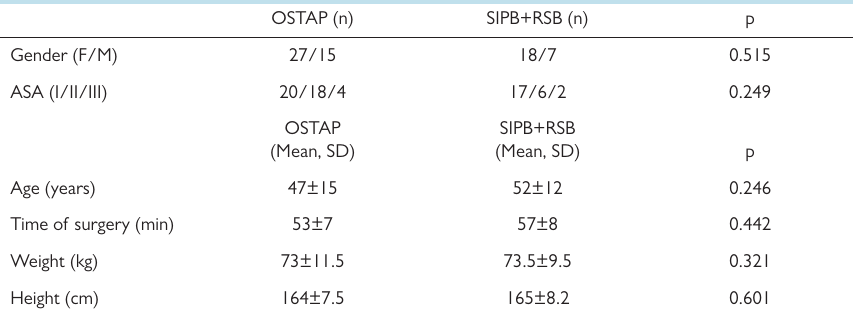
Table 1. Comparison of demographic data between groups (SD, standard deviation)